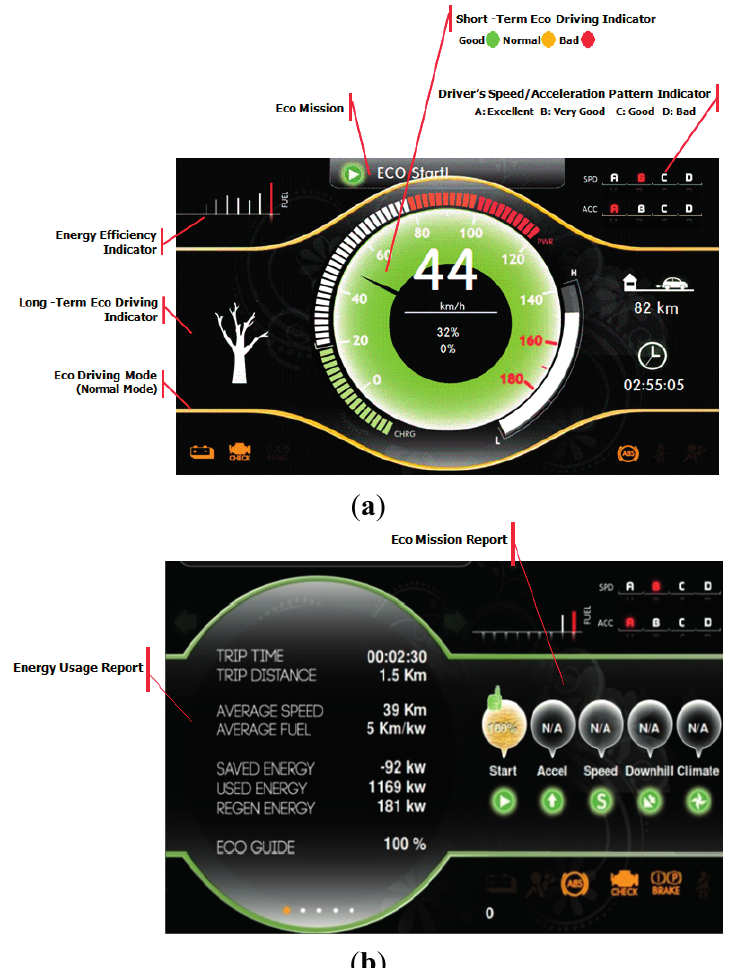
Figure 4. ( a ) Eco indicator; ( b ) Eco